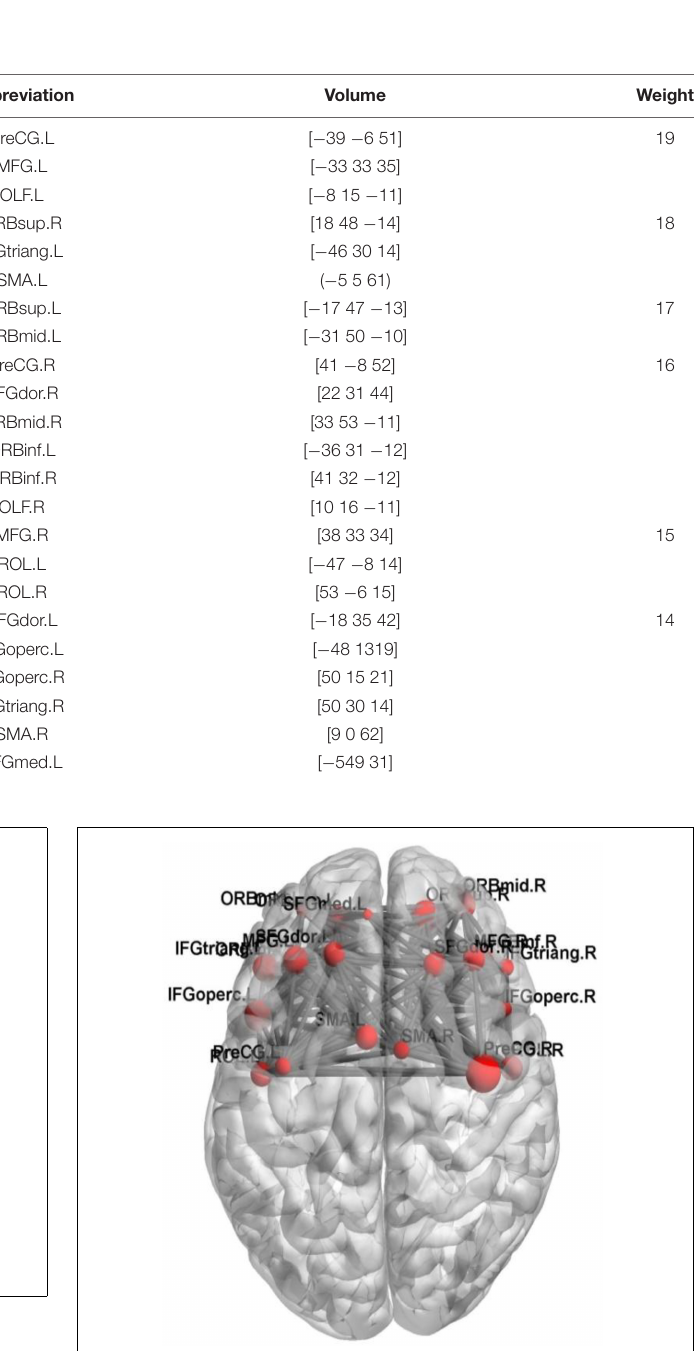
FIGURE 6 | The functional connectivity between the 23 brain